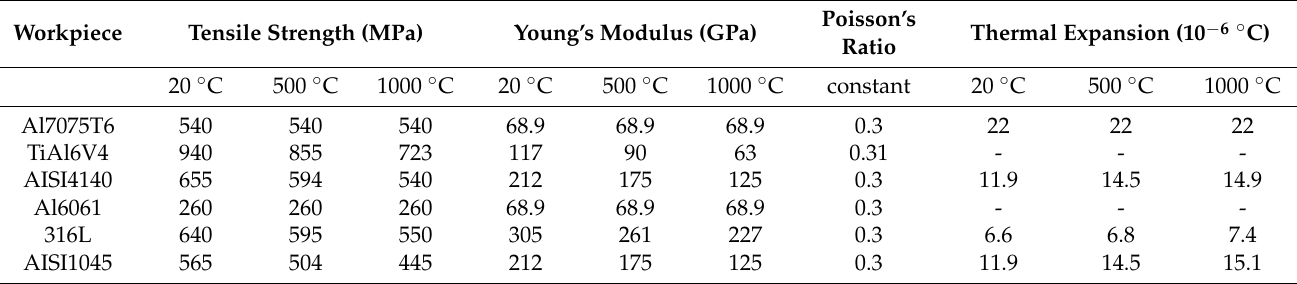
Table 2. Mechanical material properties used in the simulation.